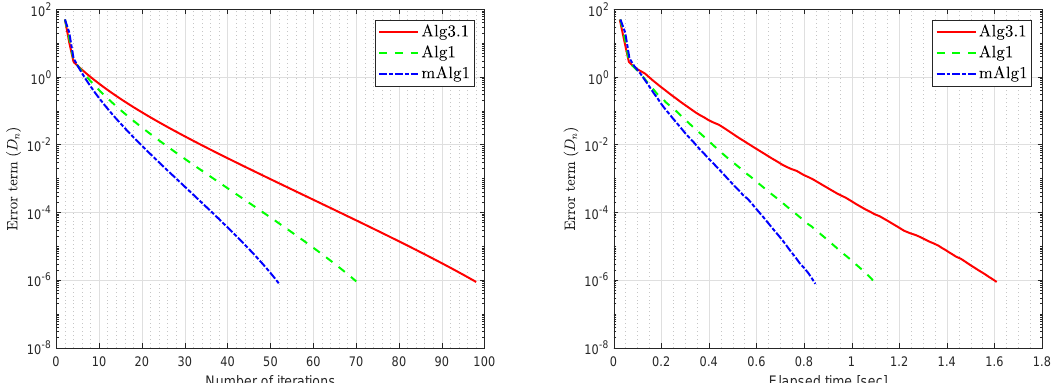
Figure 10. Example 4: Algorithm 1 (mAlg1) numerical comparison with Algorithm 3.1 (Alg3.1) in [39] and Algorithm 1 (Alg1) in [38] while m = 50.